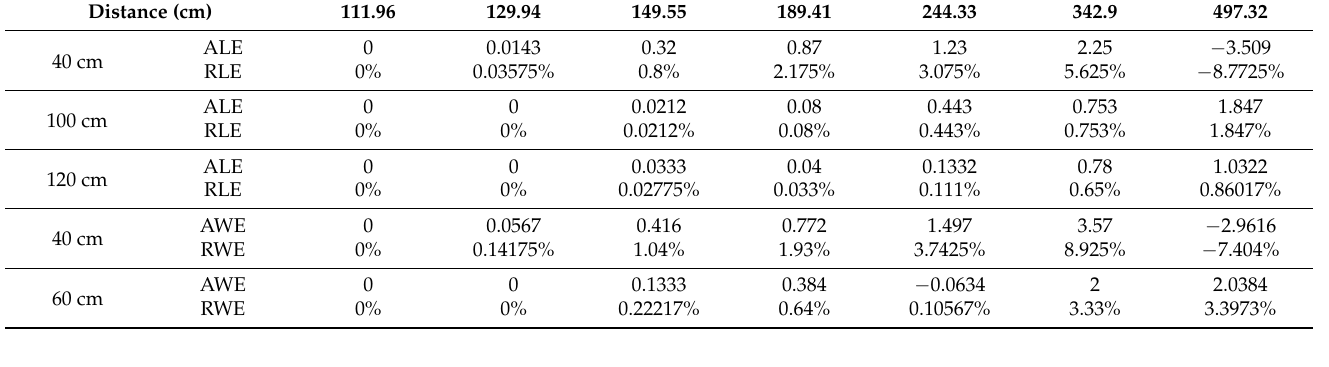
Table 4. Length and width error analysis table.